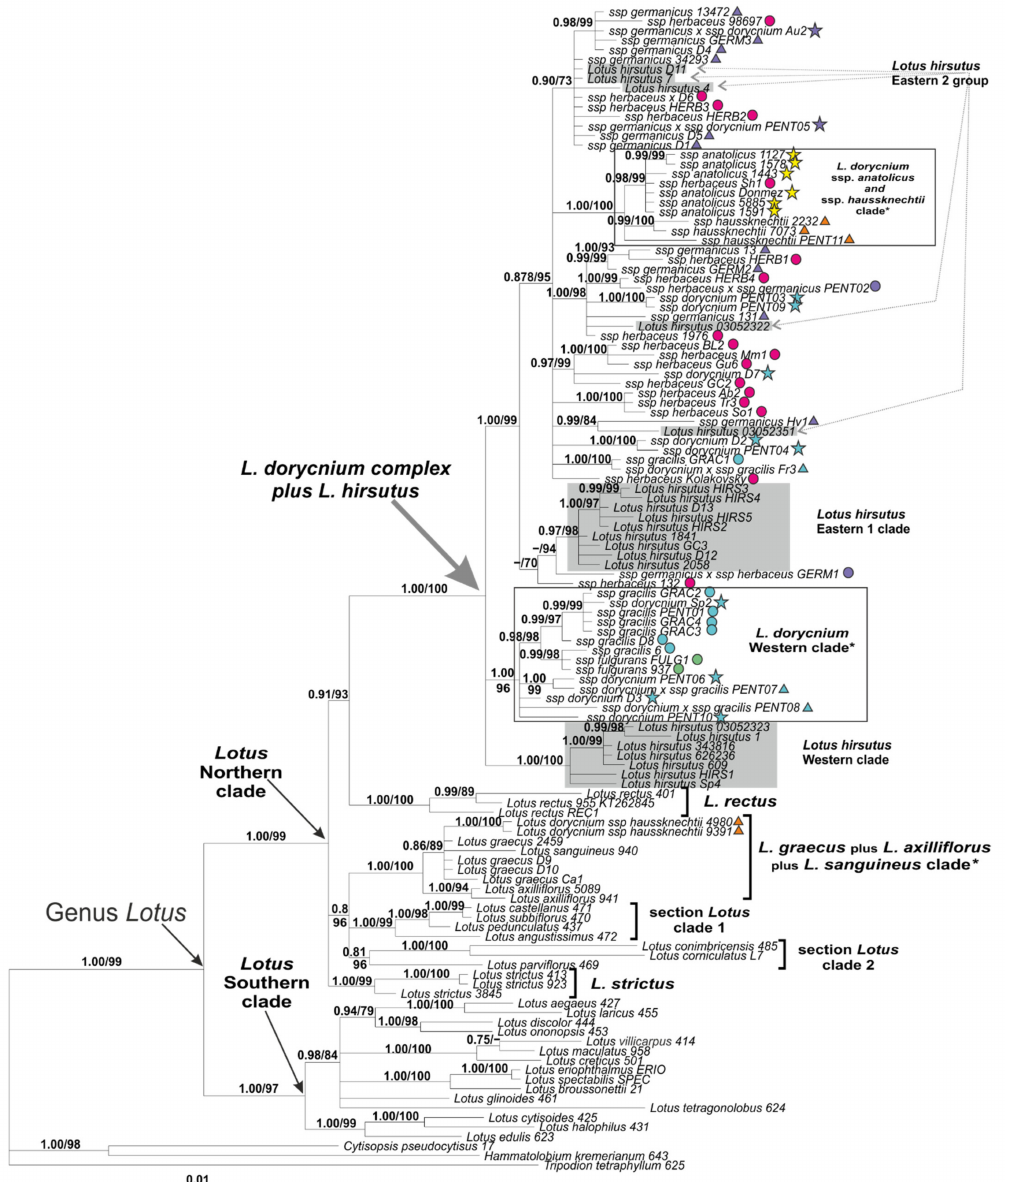
Figure 11. Phylogenetic relationships in Lotus with expanded representation of the L. dorycnium complex inferred from Bayesian analysis of the plastid DNA dataset. Branch lengths are proportional to the number of expected nucleotide substitutions; scale bar corresponds to 0.01 substitutions per site. Numbers above branches are posterior probabilities. Numbers below branches or after slashes are bootstrap support values found in ML analysis of the same dataset (values equal to or more than 0.6/60% shown). Clades slightly differing in composition from the corresponding clades in the ITS tree are marked with an asterisk. See Table 2 and Appendix A for voucher